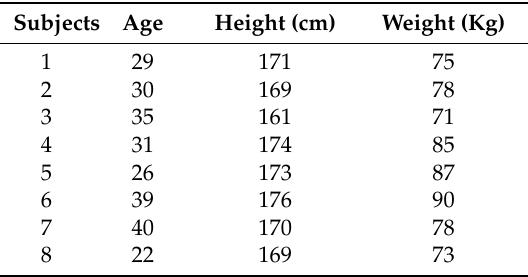
Table 2. Subjects involved in experiment process.